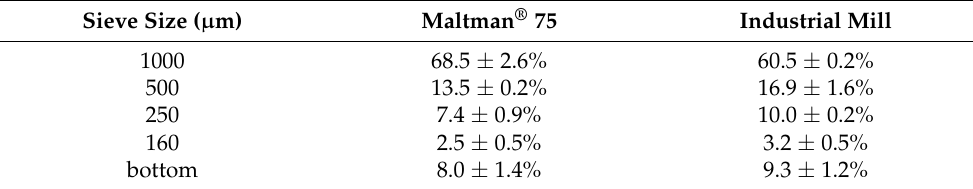
Table 2. Grist analysis performed with Prufsieb JEL 200 sieve shaker (average ± standard